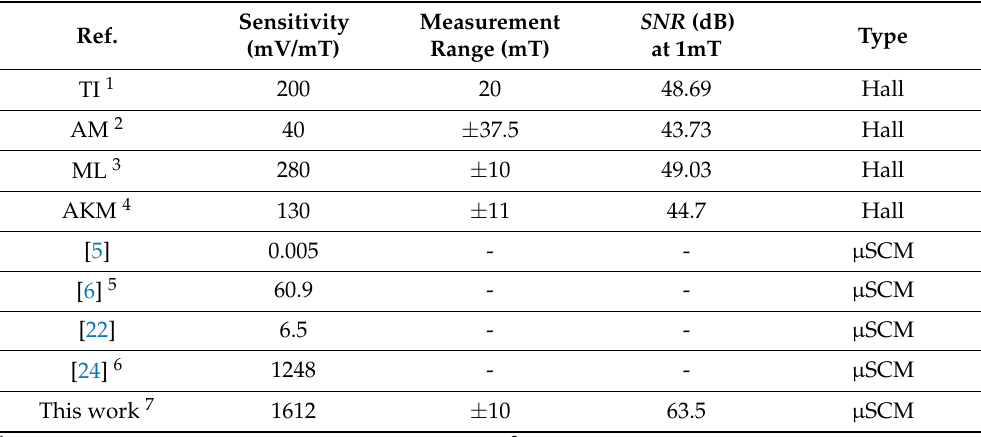
Table 3. A comparison between the fabricated µ SCM and commercial magnetic field sensors at 50 Hz input magnetic field and 800 Hz measurement